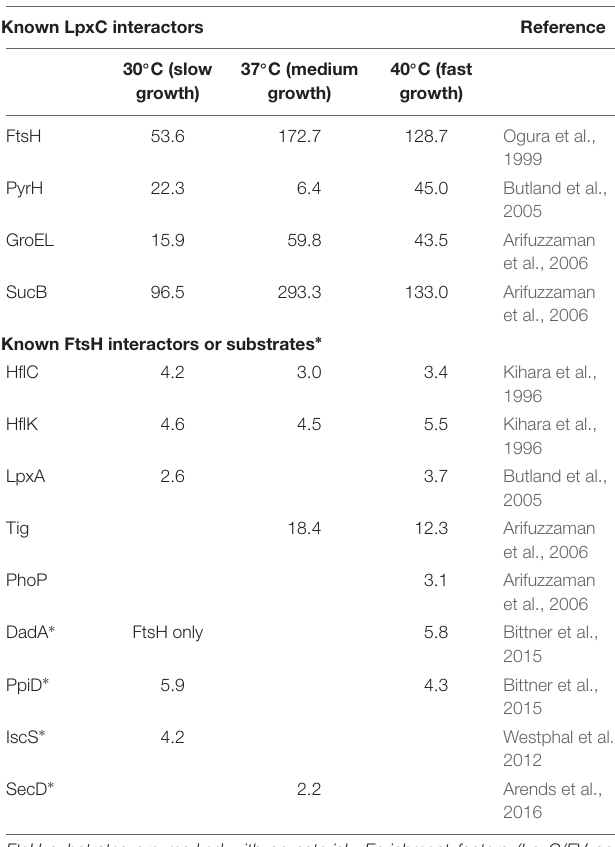
TABLE 1 | Known LpxC and FtsH interactors identified by the super-SILAC AP-MS